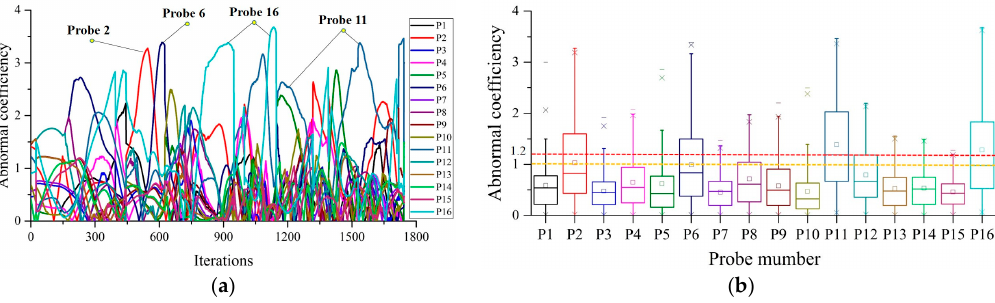
Figure 12. The abnormal coefficient and boxplot at the first 6 h of Vehicle 2. ( a ) The abnormal coefficient curves; ( b ) Boxplot of the abnormal coefficient.